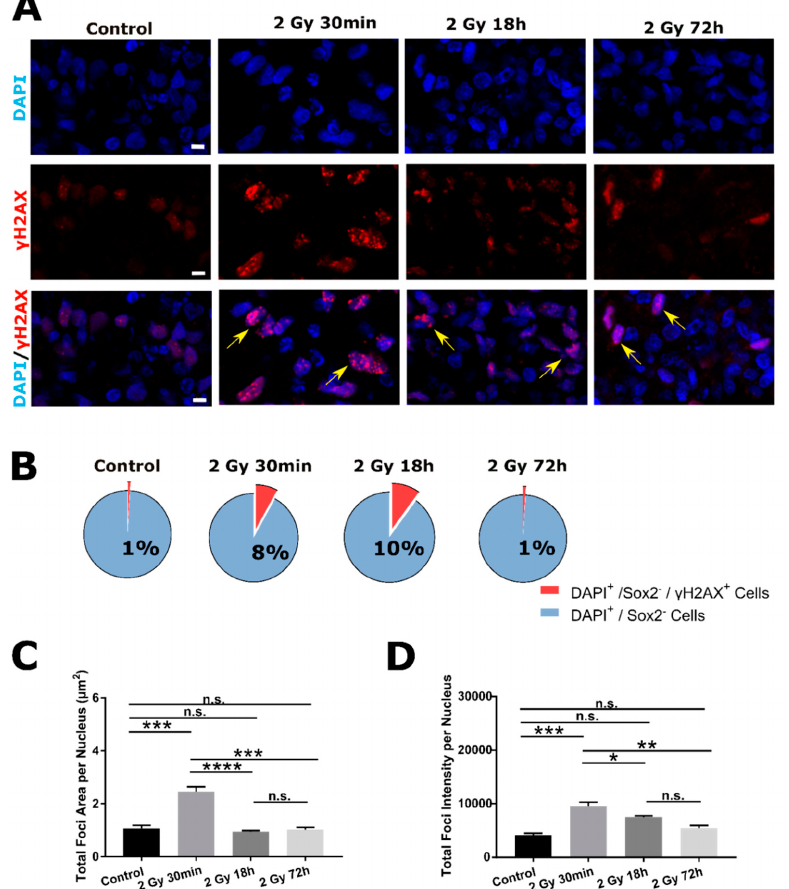
Figure 2. DSB DNA damage response of SOX2 − cells at early (30 min) and later time points (18 and 72 h) following 2 Gy irradiation, assessed by γ H2AX DSB maker. ( A ) Representative images of nuclei (DAPI, first row) that are positive for the presence of DSBs, visualized by γ H2AX antibody (red foci, second row; yellow arrows pointing at nuclei with γ H2AX + foci on merged images, third row) of Control and 2 Gy irradiated organoids (30 min, 18 and 72 h post-irradiation). ( B ) Pie charts represent percentages of the nuclei that contain γ H2AX + foci. The highest percentage of positive nuclei is detected at 30 min and 18 h following 2 Gy irradiation (respectively, 8% and 10%) followed by 72 h and Control group (both, 1%). The extent of DNA damage is evaluated by quantifying total foci area ( C ) and total foci intensity ( D ) per nucleus. The largest foci area and highest intensity are observed 30 min following 2 Gy irradiation, followed by both parameters decrease at later time point comparable to Control values (data are represented as bar charts showing foci signal mean values. N = 3 organoids per group, n = 30 ROIs per group, total amount of DAPI + cells analyzed per group n ~ 3000). Scale bar 5 µm. * p < 0.05, ** p < 0.01, *** p < 0.001, **** p < 0.0001, n.s.—non-significant (one-way ANOVA, followed by Tukey’s multiple comparisons test).